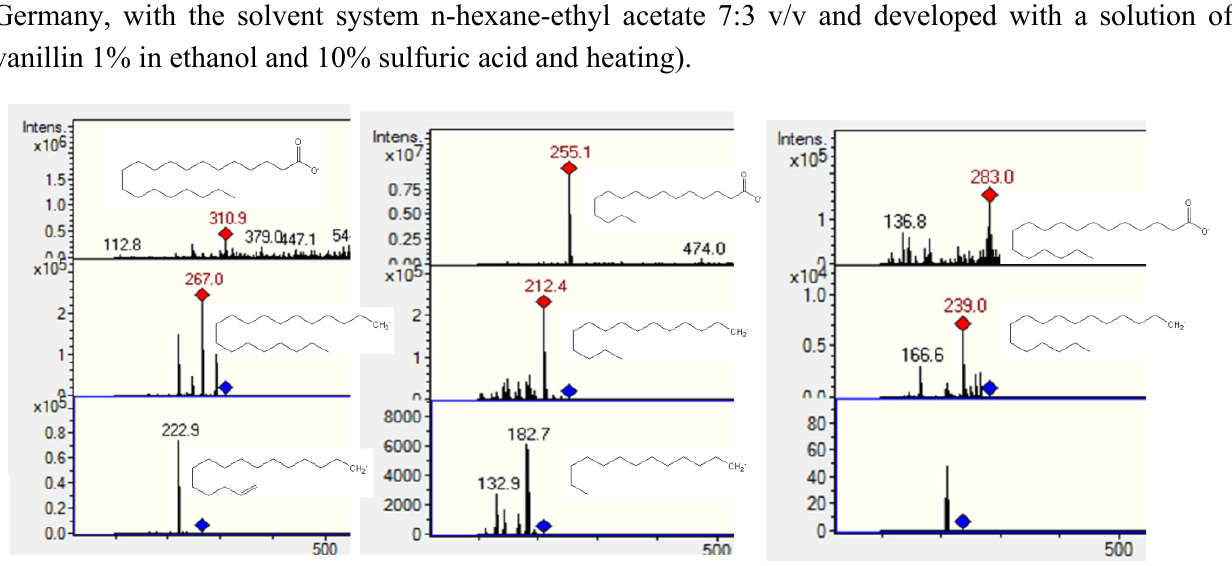
Figure 7. Structures, full scan MS and MS n spectra of Peaks 13 , 18 and 23